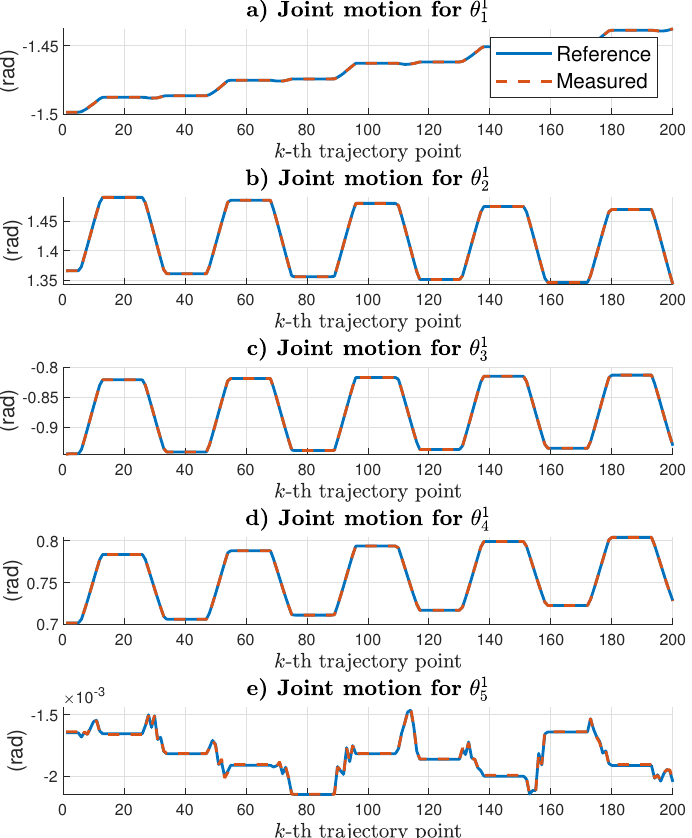
Figure 12. Motion result for manipulator 1. The “Reference” label indicates the optimal joint value provided by the CMA-ES algorithm, and the “Measured” label is the current